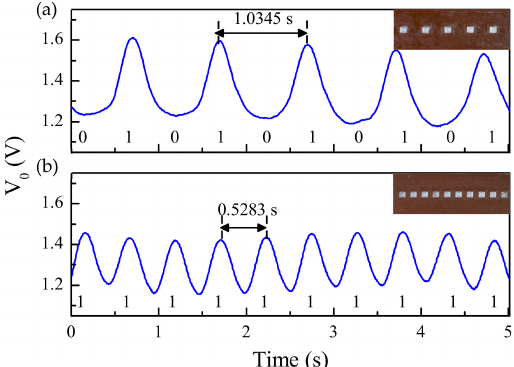
Figure 12. Measured envelope functions corresponding to the 10-bit microwave encoders imple- mented by means of embedded dielectric inclusions depicted in the inset, with ID codes “1010101010” ( a ) and “1111111111” ( b ). The harmonic feeding signal was tuned to f c = 3.9 GHz. Reprinted with permission from [30]. Copyright 2020 IEEE.